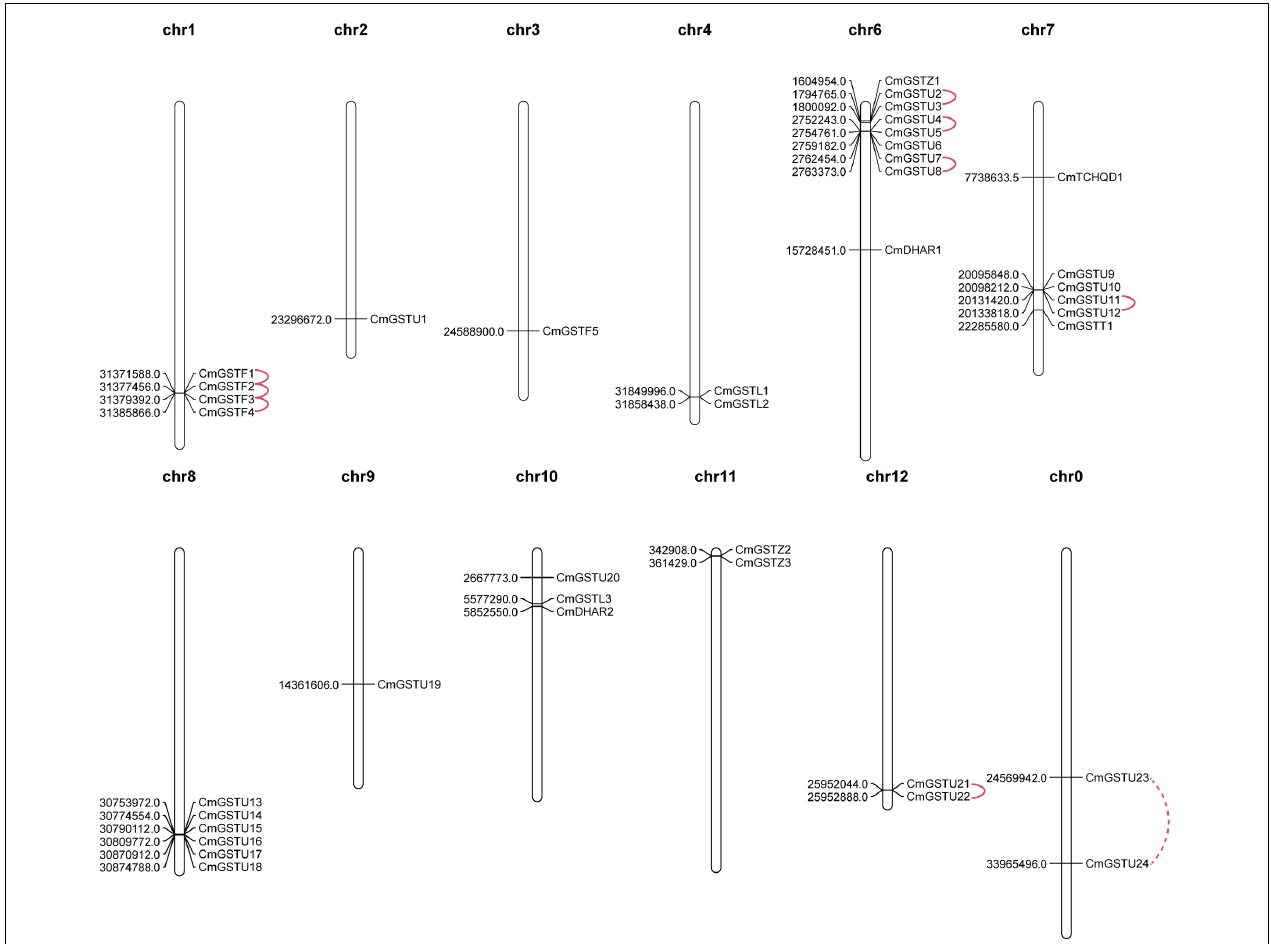
FIGURE 2 | Chromosomal locations of CmGST genes. Tandem duplication gene pairs were linked by the solid line, and the segmental duplication gene pair was linked by the dashed line.